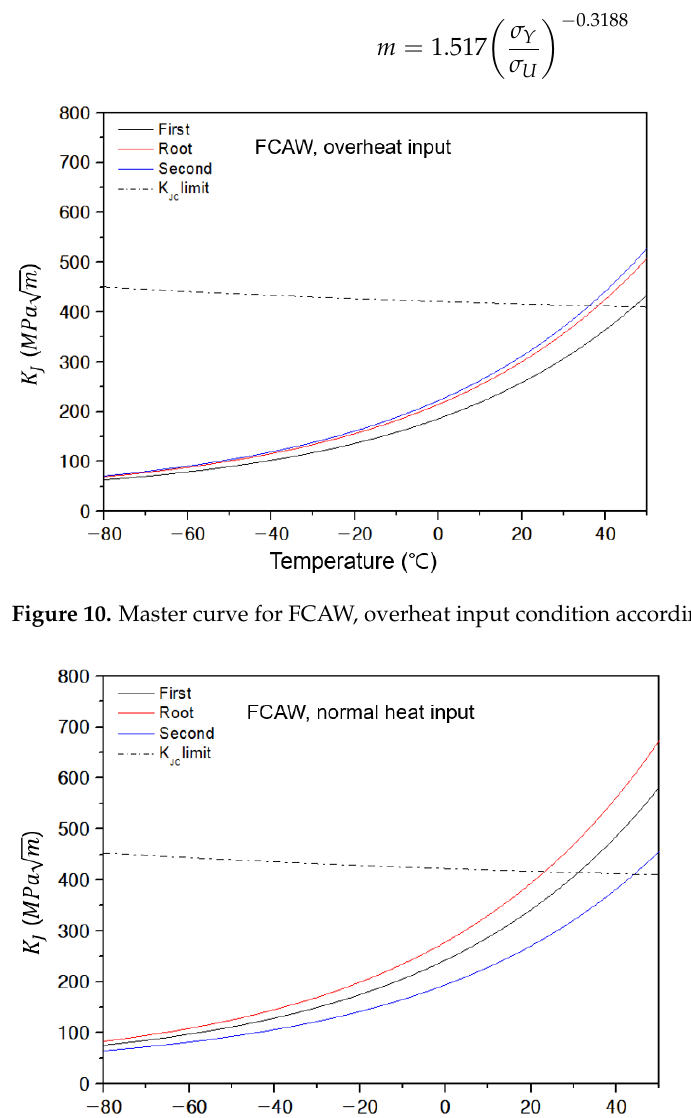
Figure 12. Master curve for SAW, normal heat input condition according to sample location. The CTOD test results are compared with the master curve to verify the validity of the master curve approach. When fracture toughness has been obtained in terms of CTOD, BS7910 suggests Equation (8) for converting CTOD values to the equivalent stress inten- sity factor. In the equation, 𝜎 (cid:3026) , 𝛿 , 𝐸 , and 𝑣 are yield strength, CTOD value, elastic mod- ulus and Poisson’s ratio, respectively. Additionally, m is the constant expressed as Equa- tion (9) for steel [8]. 𝐾 (cid:3040)(cid:3028)(cid:3047) = (cid:3496) 𝑚𝜎 (cid:3026) 𝛿𝐸 1 − 𝑣 (cid:2870) (8) 𝑚 = 1.517 (cid:3436)𝜎 (cid:3026) 𝜎 (cid:3022) (cid:3440) (cid:2879) (cid:2868).(cid:2871)(cid:2869)(cid:2876)(cid:2876)